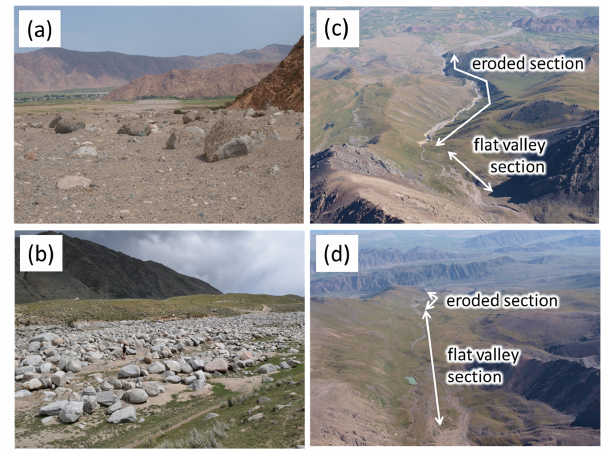
Figure 6. Flood deposits and valley landforms in the Jeruy (a, c) and Karateke (b, d) Valleys (Photos a : 13 August 2014, b : 15 Au- gust 2015, c, d : 21 August